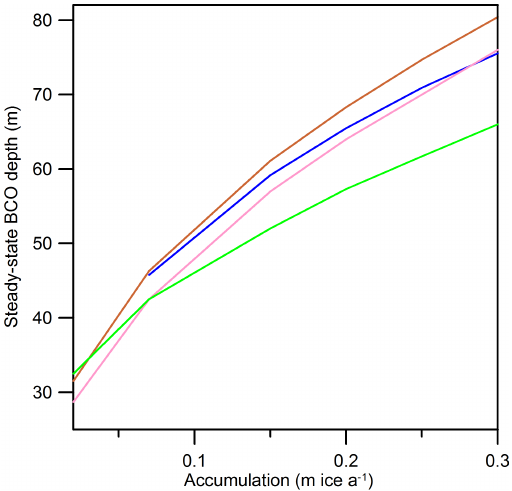
Figure 10. Variation of steady-state BCO depth with ¯ a using the Herron and Langway (brown line), Ligtenberg (green line), Simonsen (pink line), and transition (blue line) models. Simonsen and Ligtenberg results are taken from